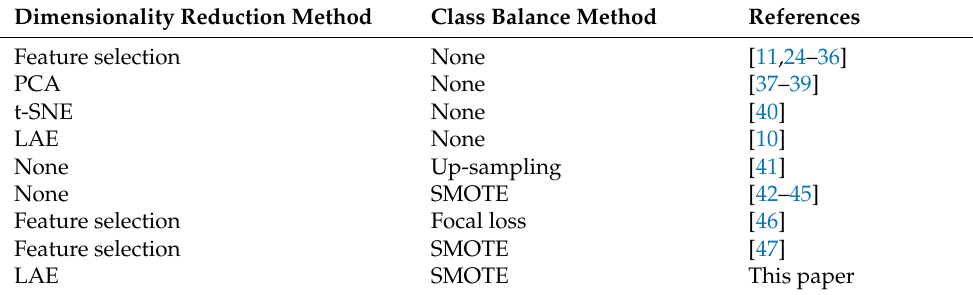
Table 1. Review of related